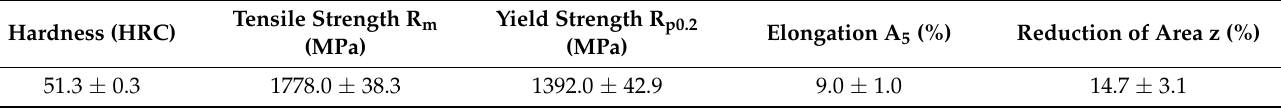
Table 3. Determined material data of L-PBF samples at room temperature by tensile